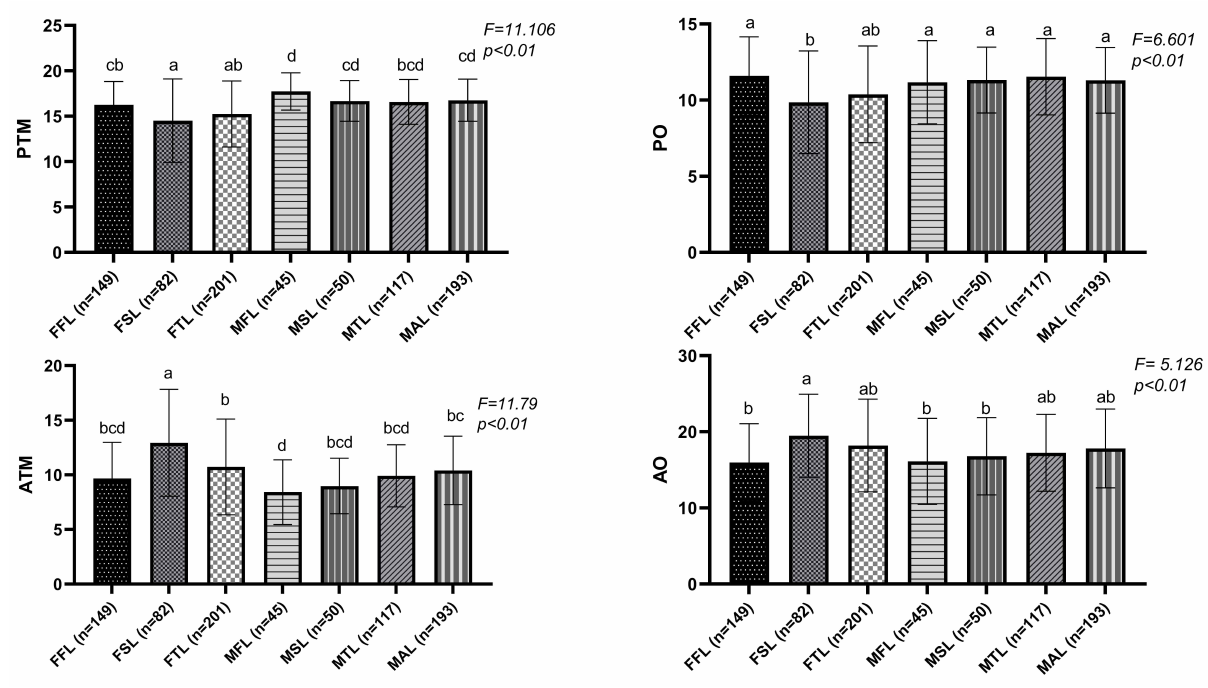
Fig. 2. Comparisons of PABSS’ subdimensions according to female and male football players’ league status . Values are expressed as a mean and standard deviation; F results of One-Way ANOVA; abcd Results of Tukey HSD; p < 0.01. p values, 95% confidence interval; PTM, Prosocial teammate; PO, Prosocial opponent; ATM, Antisocial teammate; AO, Antisocial opponent; FFL, Female first league; FSL, Female second league; FTL, Female third league; MFL, Male first league; MSL, Male second league; MTL, Male third league; MAL, Male amateur